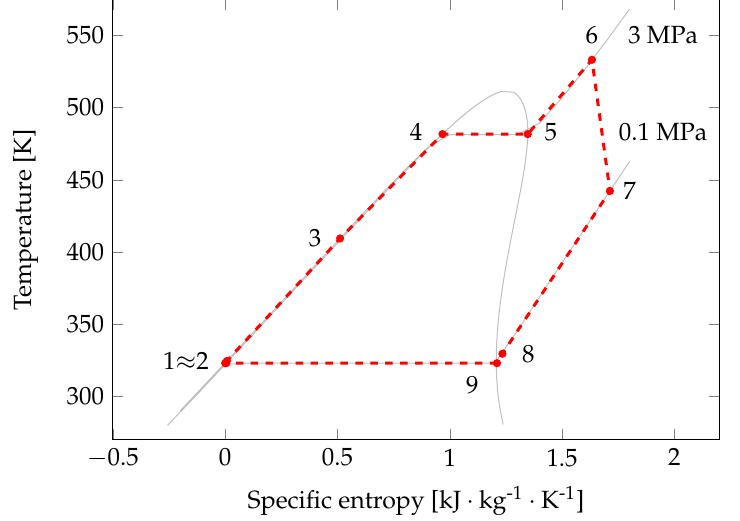
Figure 5. Saturation curve of cyclopentane in a T − s diagram, showing the thermodynamic cycle state points of the organic Rankine cycle